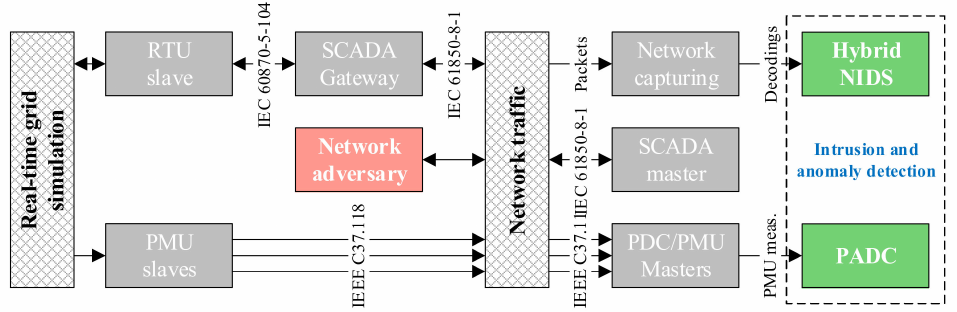
Figure 8. Overview of the experimental setup to evaluate the network intrusion and anomaly detection